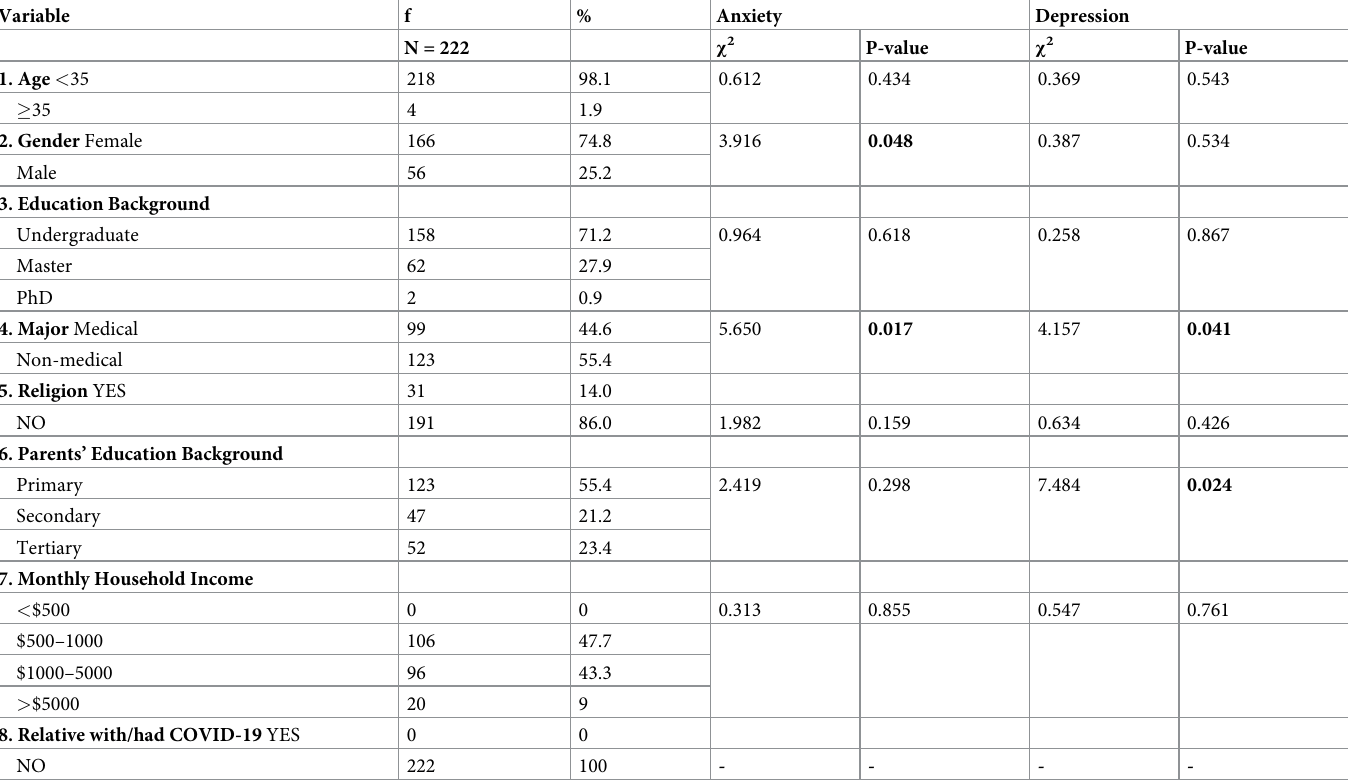
Table 5. Descriptive analysis of association between sociodemographic characteristics and psychological state on the Chinese In China group. Variable f